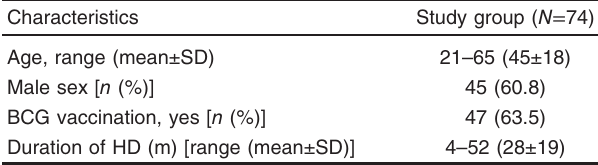
Table 1 Demographic data of the studied patients Characteristics